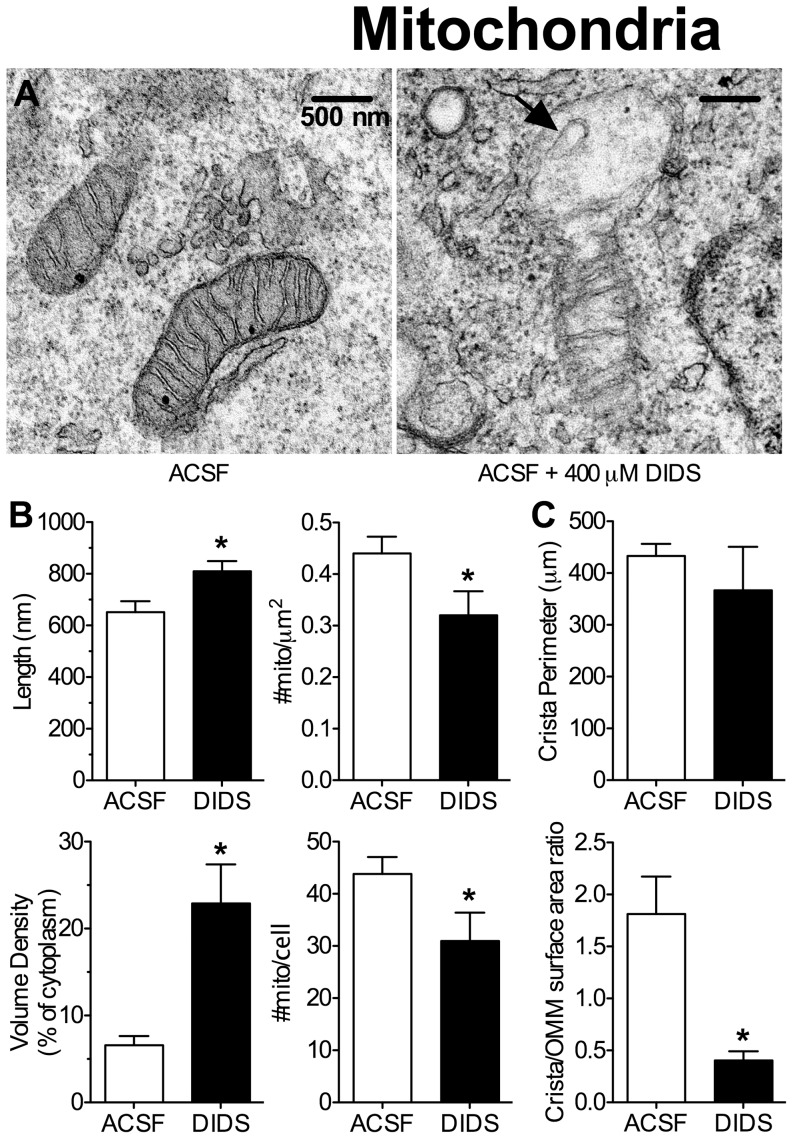
DIDS (400 µM) causes mitochondrial swelling and cristae reduction.DIDS treated mitochondria were longer, fewer in number, and had markedly reduced cristae density. (A) Sample TEM images of mitochondria from neurons treated as indicated for 24 hrs. Arrow indicates “ballooning” of outer mitochondrial membrane (OMM). (B) Summary of mitochondrial morphology-related parameters from Fig. 4A. (C) Summary of cristae morphology-related parameters from Fig. 4A. Data are mean ± SEM. Asterisks (*) indicate significant difference from normoxic controls (p<0.05).